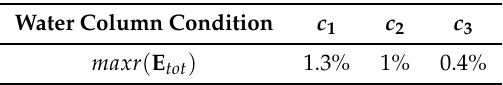
Table 2. Maximum relative spread of the total downward radiance E tot at the seabed level, due to the variability of the seabed reflectance and coupling